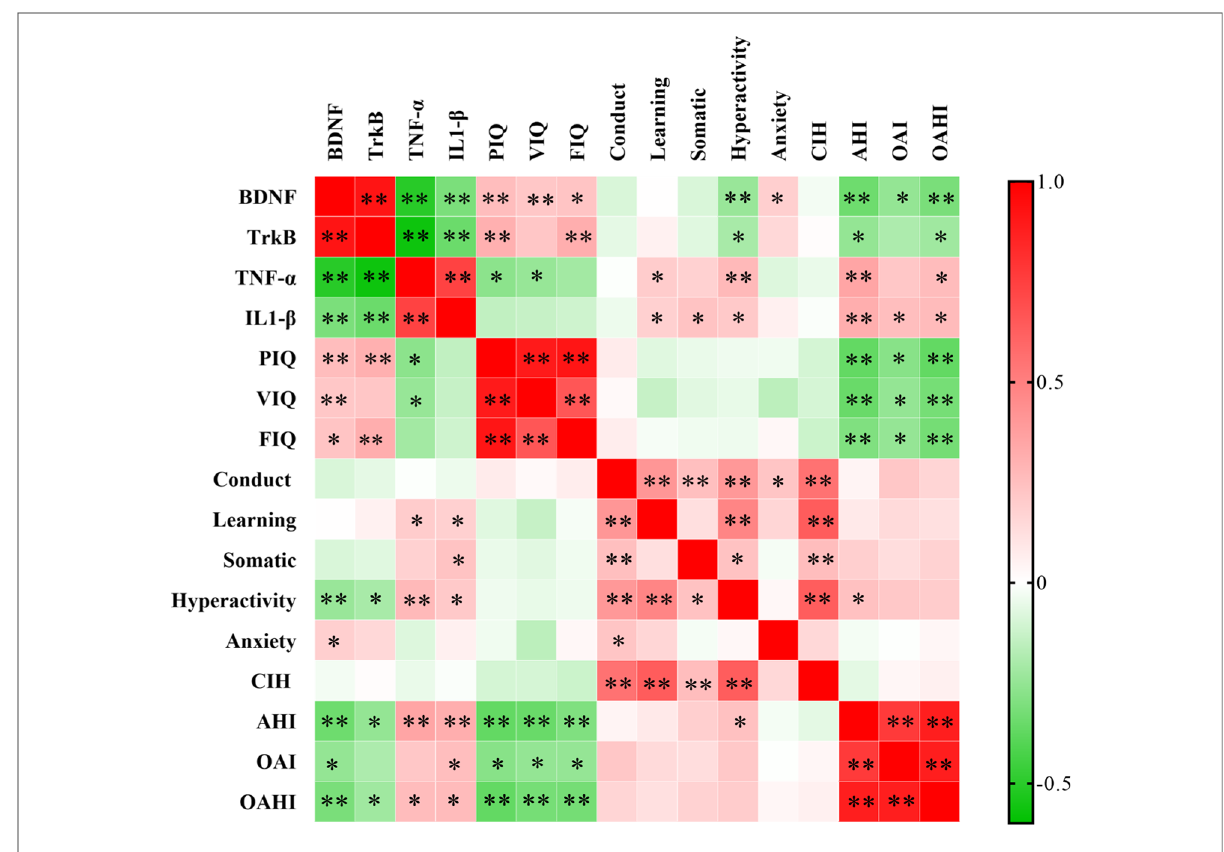
FIGURE 3 Correlation analysis between BDNF, TrkB, IL-1 β , TNF- α , and cognitive parameters. ** P <0.01, * P <0.05. BDNF, brain-derived neurotrophic factor; TrkB, tyrosine kinase receptor B; IL-1 β , interleukin-1beta; TNF- α , tumor necrosis factor-alpha.